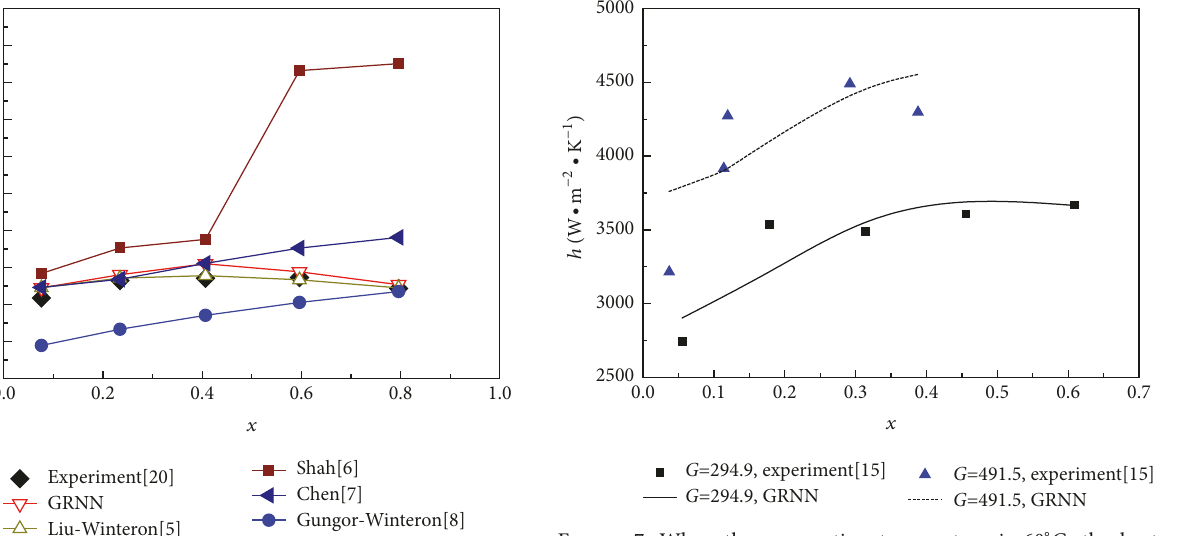
Figure 7: When the evaporation temperature is 60 ∘ C, the heat transfer coefficient of R245fa changes with dry and mass flux